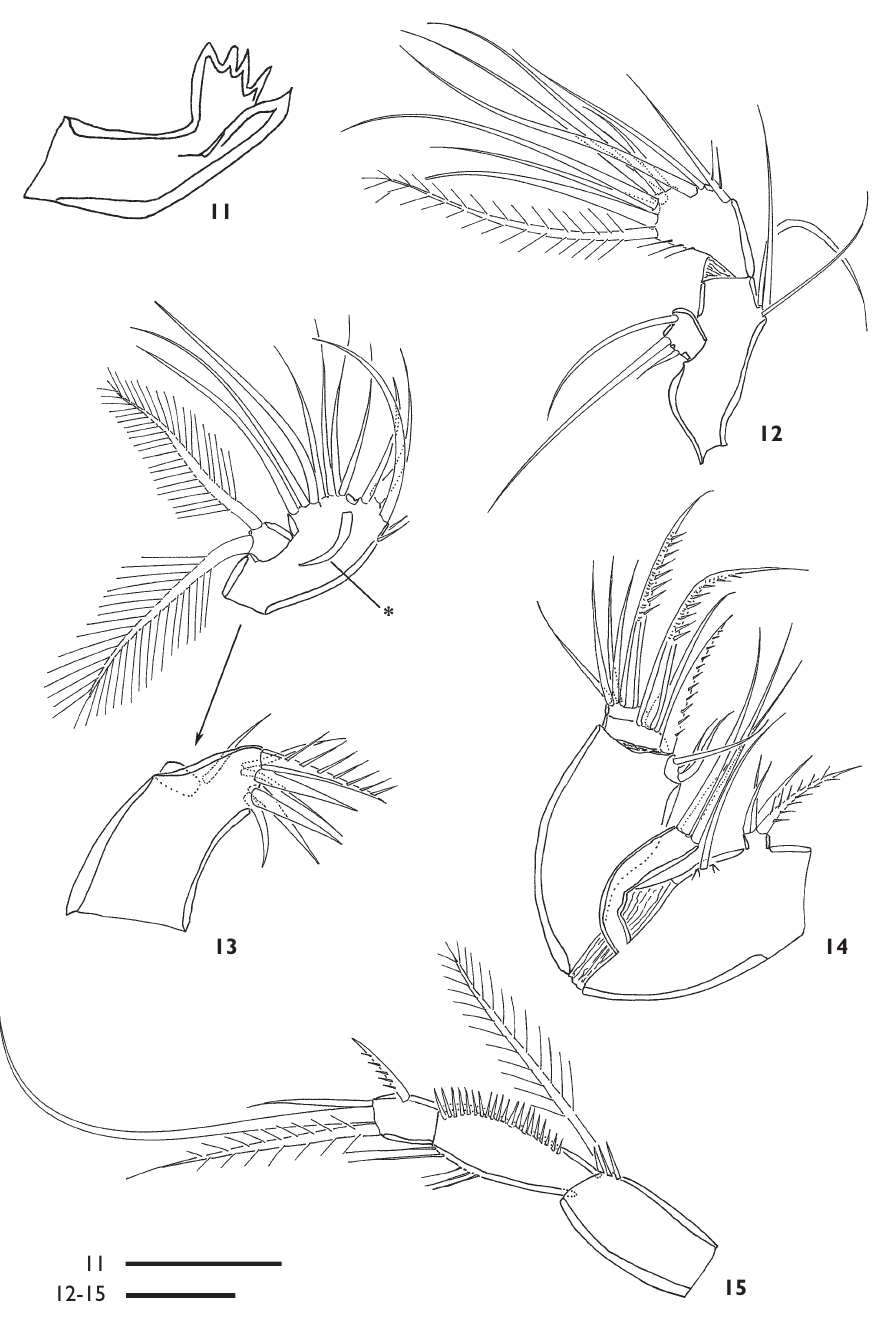
Figures 11-15. Chaulionyx paivacarvalhoi gen. et sp. n. ♀ : 11 mandibular gnathobase 12 mandibular palp 13 maxillule [asterisk indicating cuticular reinforcement] 14 maxilla 15 maxilliped. Scale bars = 10